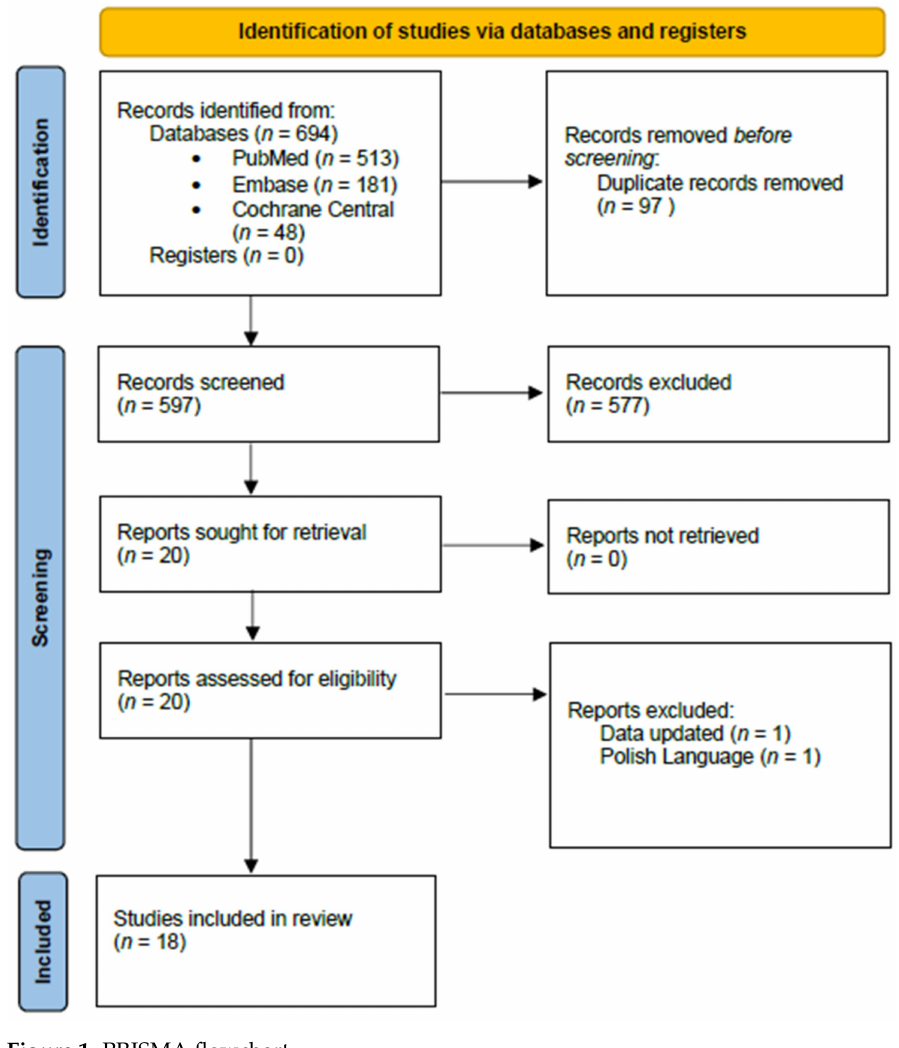
Figure 1. PRISMA